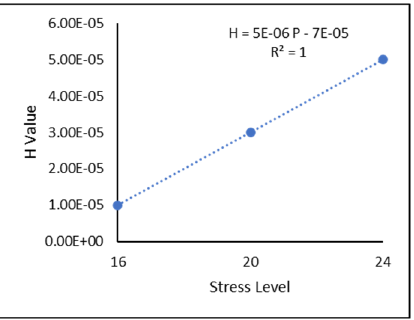
Figure 31. H -value as a function of stress amplitude.